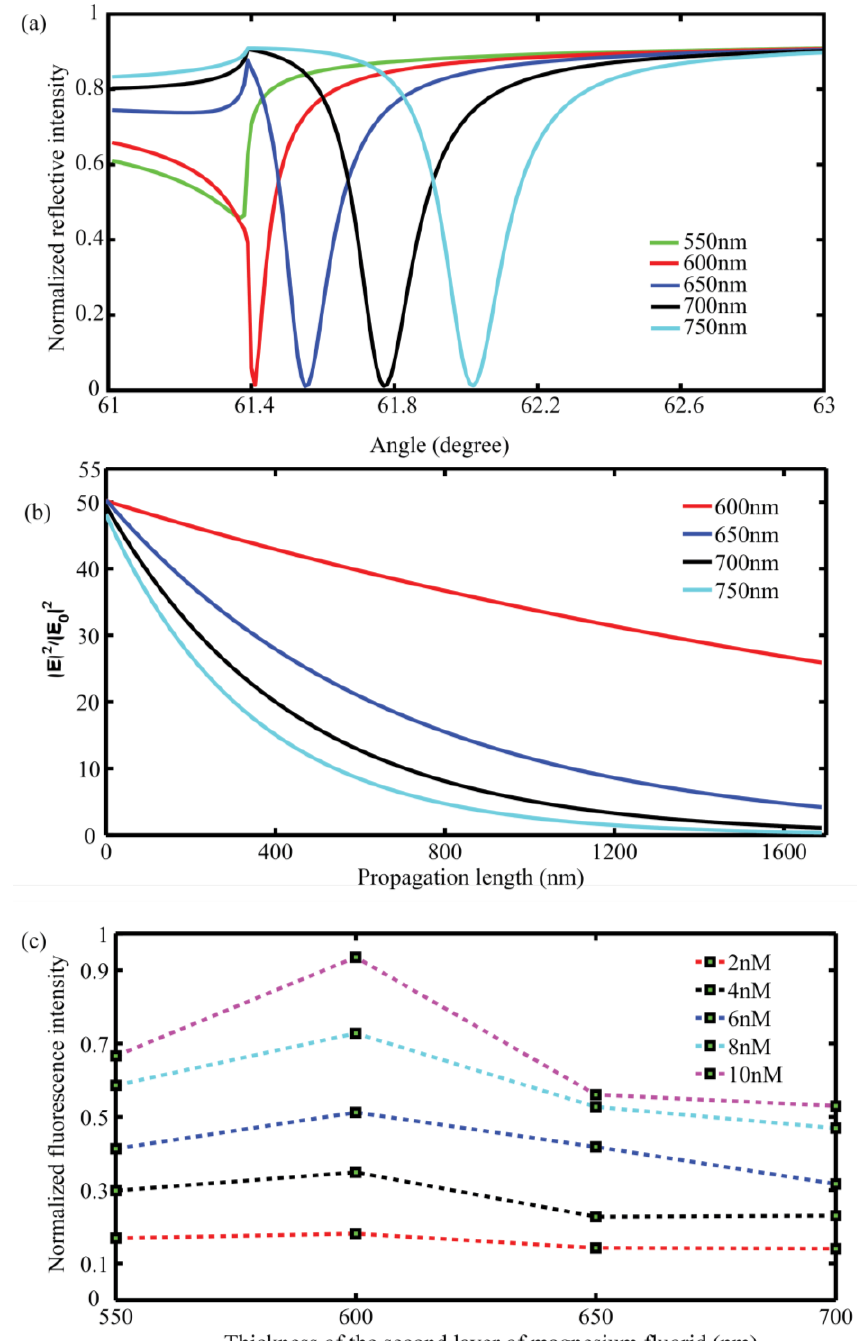
Figure 4. Resonance curves ( a ) and electric field distribution ( b ) beyond the sensor films directly into sensed medium simulated with various thicknesses of second layer of magnesium fluoride 600 nm (red), 650 nm (blue), 700 nm (black), 750 nm (cyanine) generated by symmetrical CPWR. Thicknesses of the first layer of magnesium fluoride and Au metal film are 500 nm and 40 nm, respectively. Wavelength of the incident light is 632.8 nm, n(BK ) = 1.515, n(MgF ) = 1.38, n(Au) = 0.3123 + 3.146i; ( c ) Fluorescence 7 2 intensities against to different concentrations responding to sensor films with different thicknesses of second MgF layer ranging from 550 nm to 700 2